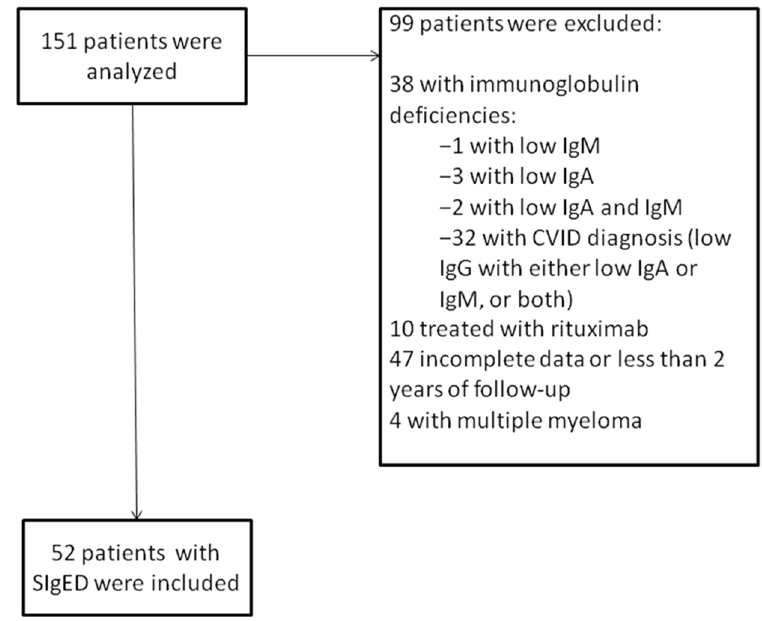
Figure 1. Flow chart of patients analyzed.